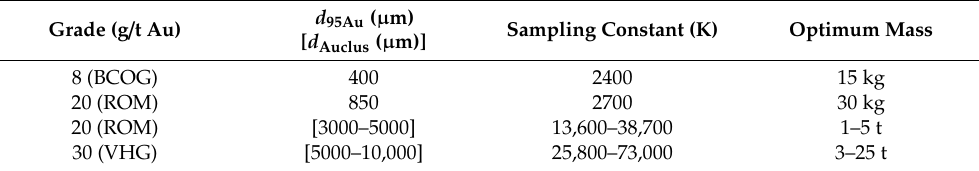
Table 28. Range of theoretical sample mass values.